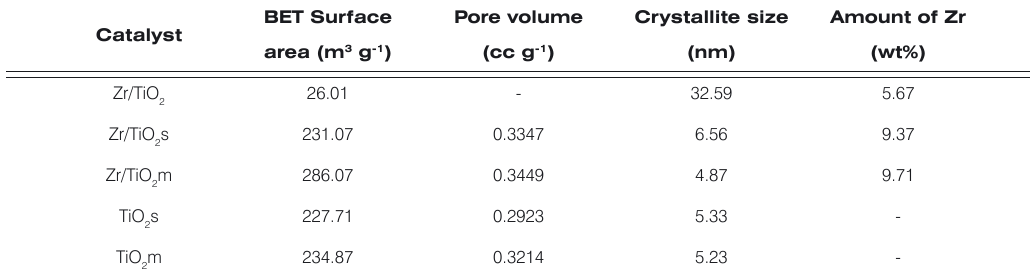
Table 1. N sorption data, crystallite size of titania particles and amount of Zr present on different systems 2